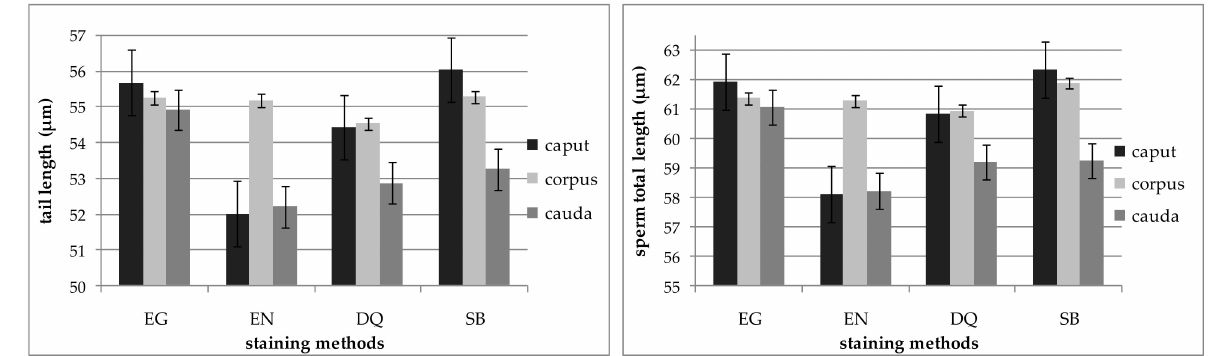
Figure 2. Tail length and total length of sperm collected from the caput, corpus and cauda of the epididymides depending on the staining method (EG, EN, DG, SB). Bars represent means ± SEM (number of analyzed cells =